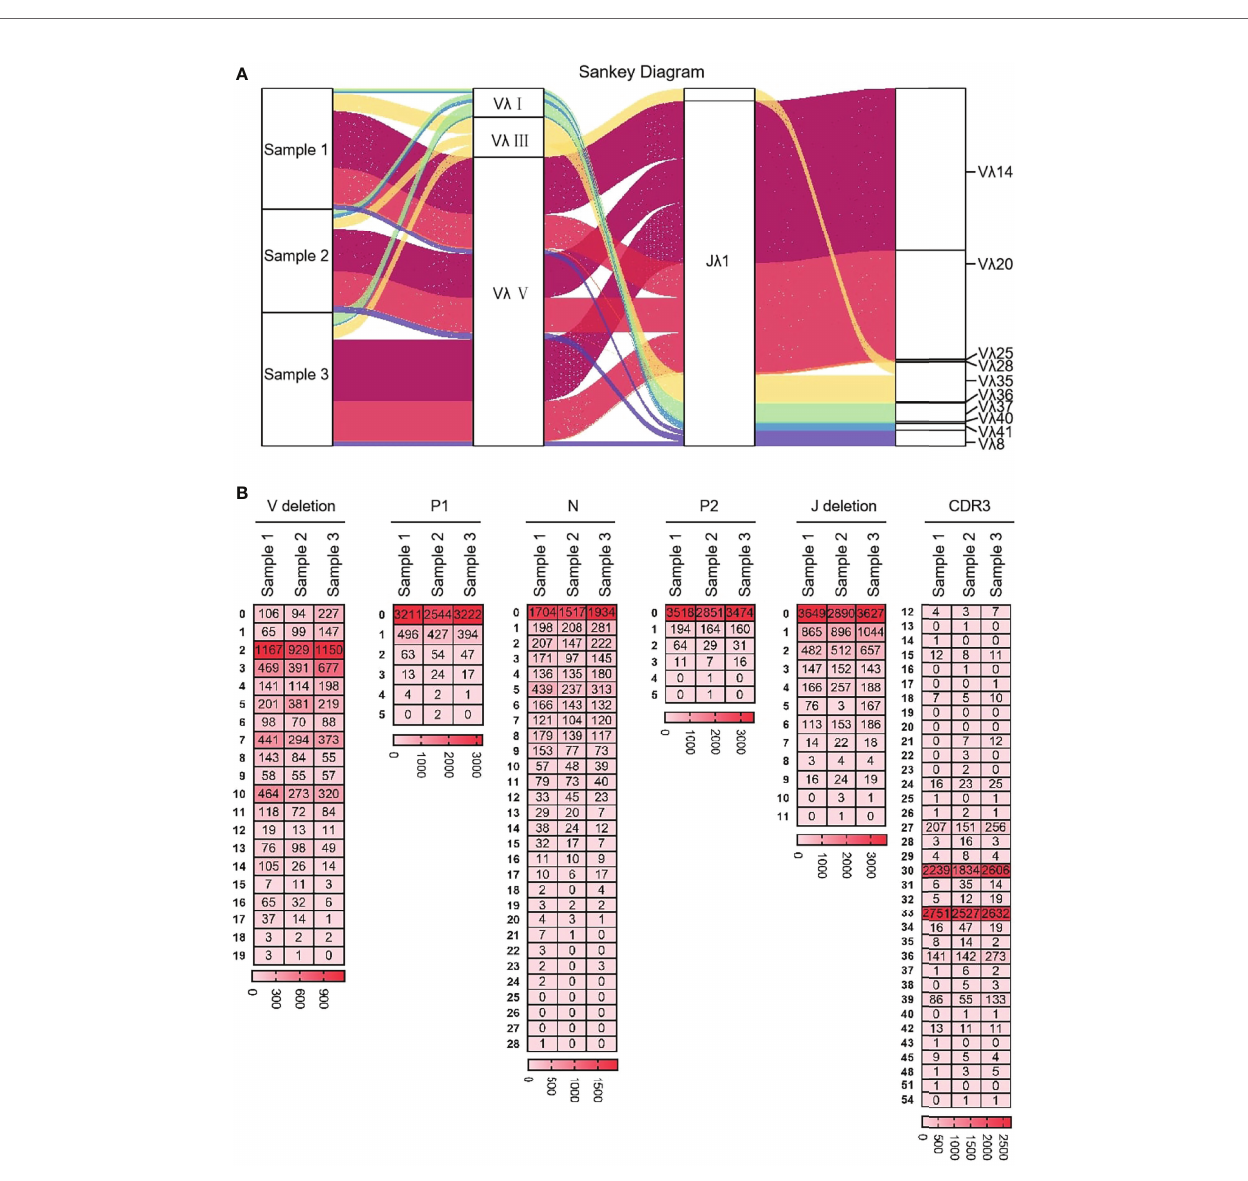
FIGURE 12 | The diversity of VJ recombination and CDR3 length in yak IgL( l ). (A) The sankey diagram of VJ recombination in yak IgL( l ); (B) the nucleotides distribution of V deletion, P1 nucleotide, N nucleotide, P2 nucleotide, J deletion and CDR3 in yak IgL( l